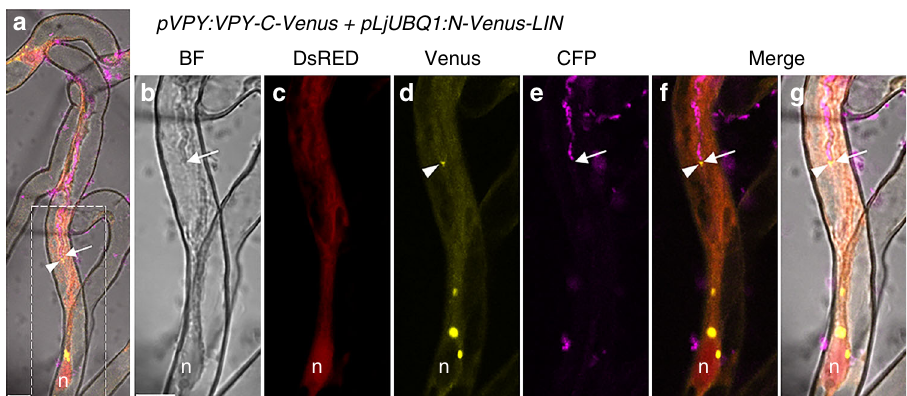
Fig. 6 VPY interacts with LIN during rhizobial infection thread formation. a – g Live cell confocal images showing a root hair undergoing infection in a sunn-2 composite plant containing pVPY: VPY-C-Venus , pLjUBQ1:N-Venus-LIN and pAtUBQ:DsRED as a transgenic marker. Bimolecular Fluorescence Complementation (BiFC) experiments were performed using N-Venus fused to LIN driven by pLjUBQ1 promoter and C-Venus fused to VPY driven by VPY promoter as in Fig. 5h. One representative image is shown out of seven imaged ongoing infection sites in two sunn-2 composite plants. Split Venus fl uorescence was imaged 4 days after inoculation with Sm2011-CFP, in a root hair hosting an elongating infection thread. Venus fl uorescence was associated notably to the tip of the growing infection thread. As in other root hairs, Venus fl uorescence was also found associated to a number of other puncta in the nucleus vicinity or along the cytoplasmic bridge. DsRED, Venus and CFP were pseudo coloured in red, yellow and magenta respectively. Dashed white line box in a indicates the regions shown in ( b – g ). Arrows, infection thread growing tip; arrowheads, infection thread tip-associated Venus- labelled puncta. n, nucleus. Scale bars, 10 µ m